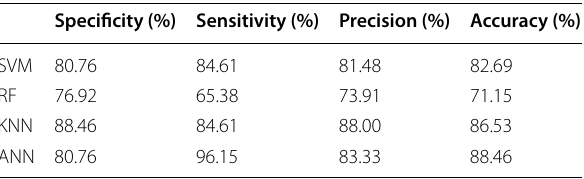
Table 6 Evaluation parameters of classification systems based on selected features from structural magnetic resonance images Specificity (%) Sensitivity (%) Precision (%) Accuracy (%)